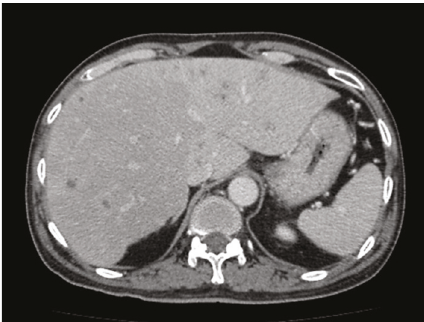
Figure 1: Axial computed tomography (CT) scan (portal venous phase) shows multiple small abscesses throughout both lobes of the liver. Transient hepatic attenuation differences (THAD) due to left portal vein thrombosis were well visualized. Note the normal- appearing spleen.